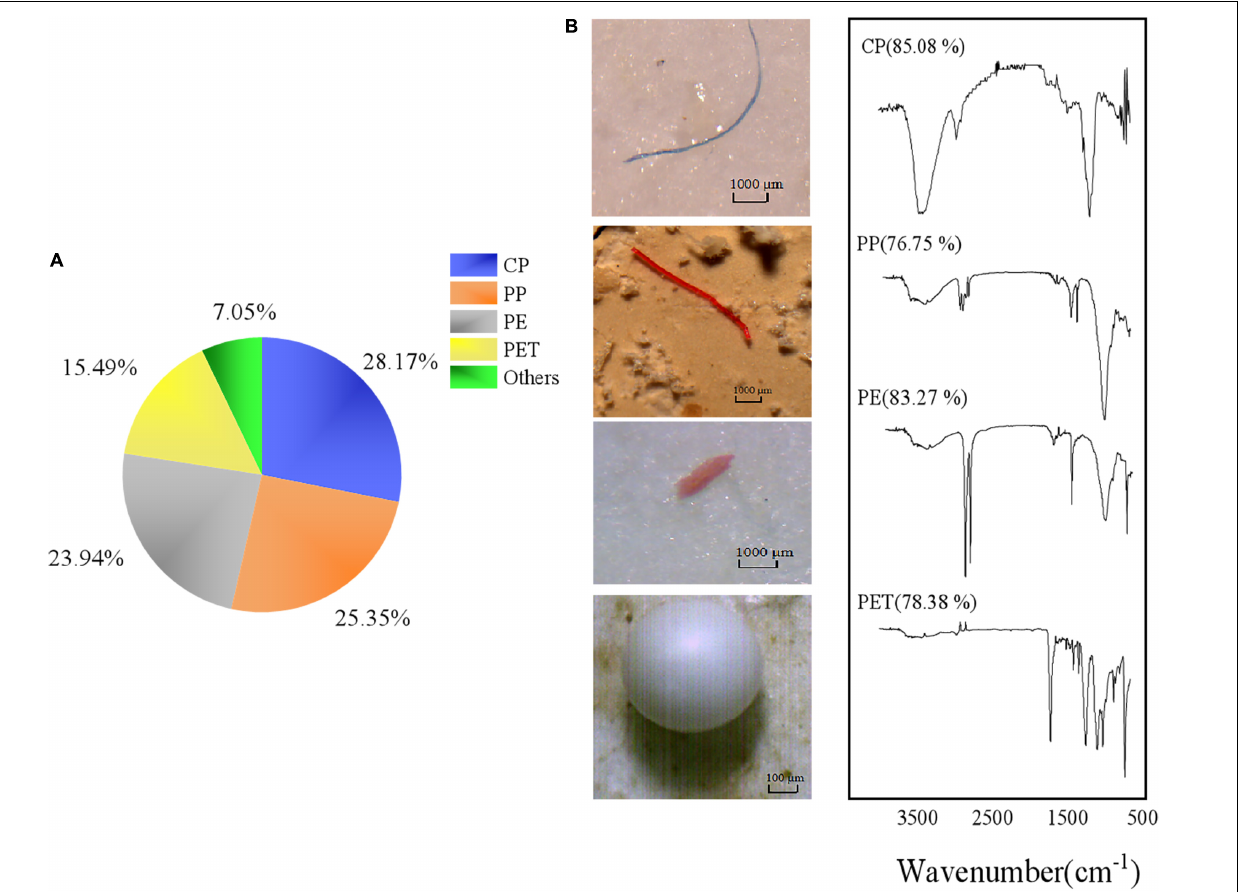
FIGURE 7 | Type distribution (A) and material spectra (B) identified by µ -FT-IR microscopy of the MPs observed in barnacles and wild bivalves. Proportions less than 5% were classified as others, including polymethacrylates (PMA, 4.23%), polyacrylonitrile (PAN, 1.41%), and poly(urethane:ethylene terephthalate) (PU-PET,